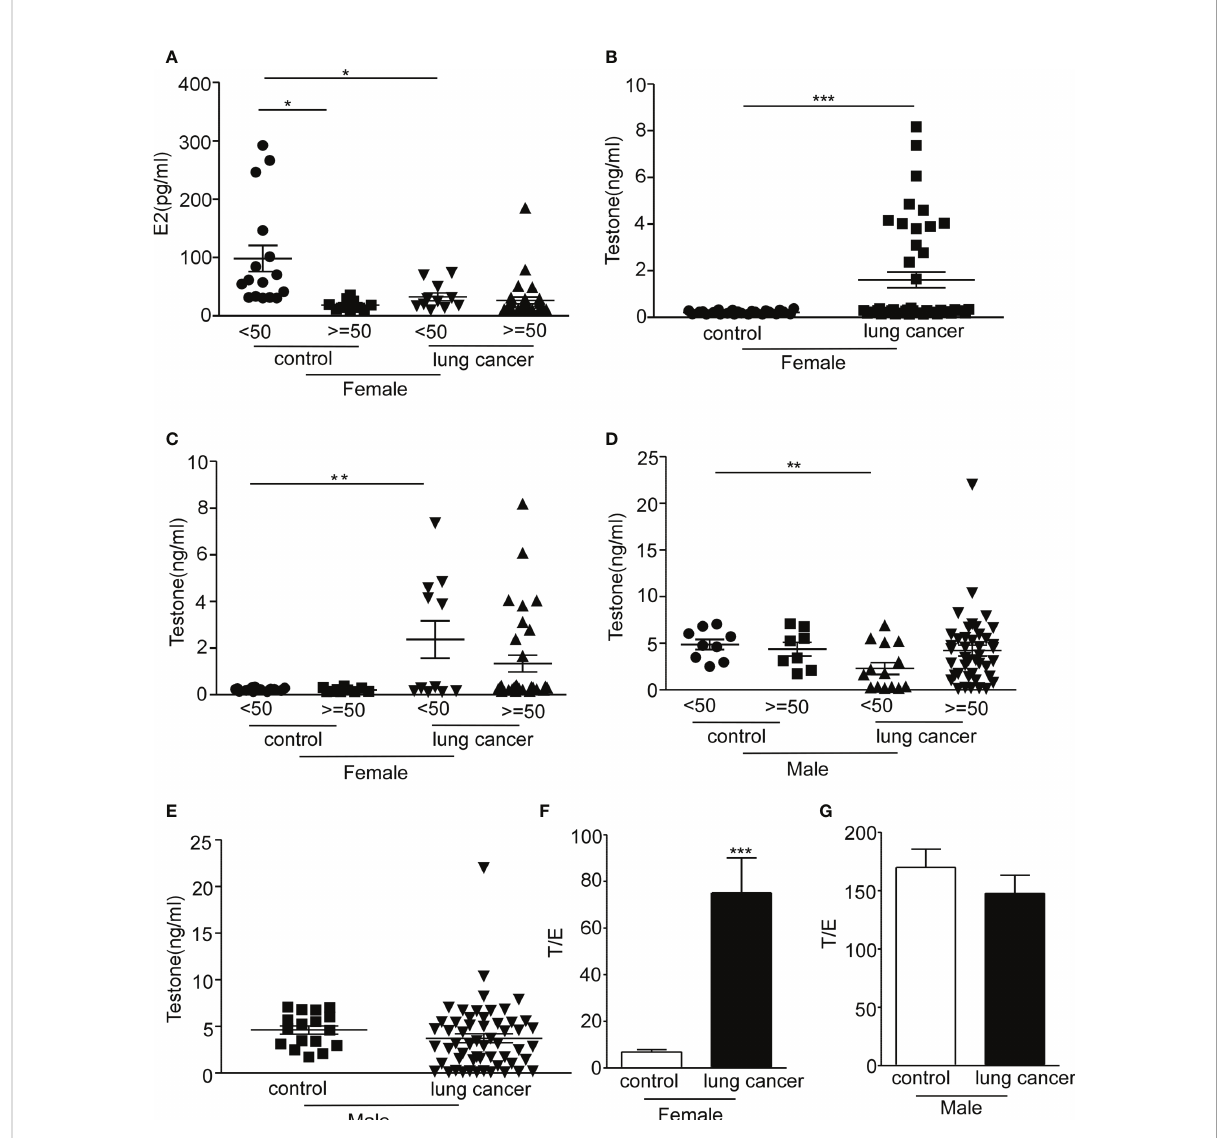
FIGURE 4 Serum concentration of sex hormone in lung cancer patients. The serum estradiol and testosterone levels were examined by CMIA. (A) The concentration of estradiol in serum (pg/ml) was analyzed in female non-small cell lung cancer (NSCLC) patients and control at different ages. (B) The serum levels of testosterone (ng/ml) were detected in female NSCLC patients and control. (C) The serum concentration of testosterone (ng/ml) was analyzed in female NSCLC patients and control at different ages. (D) The concentration of estradiol in serum (pg/ml) was analyzed in male NSCLC patients and control at different ages. (E) The serum concentration of testosterone (ng/ml) was examined in male NSCLC patients and control. (F) Ratio of testosterone to estradiol (T/E) in women with lung cancer and control. (G) Ratio of testosterone to estradiol (T/ E) in men with lung cancer and control. * P < 0.05, ** P < 0.005, *** P < 0.0001; Mann – Whitney test (two-tailed) and non-paired Student ’ s t -test. E2, estrogen; T/E,